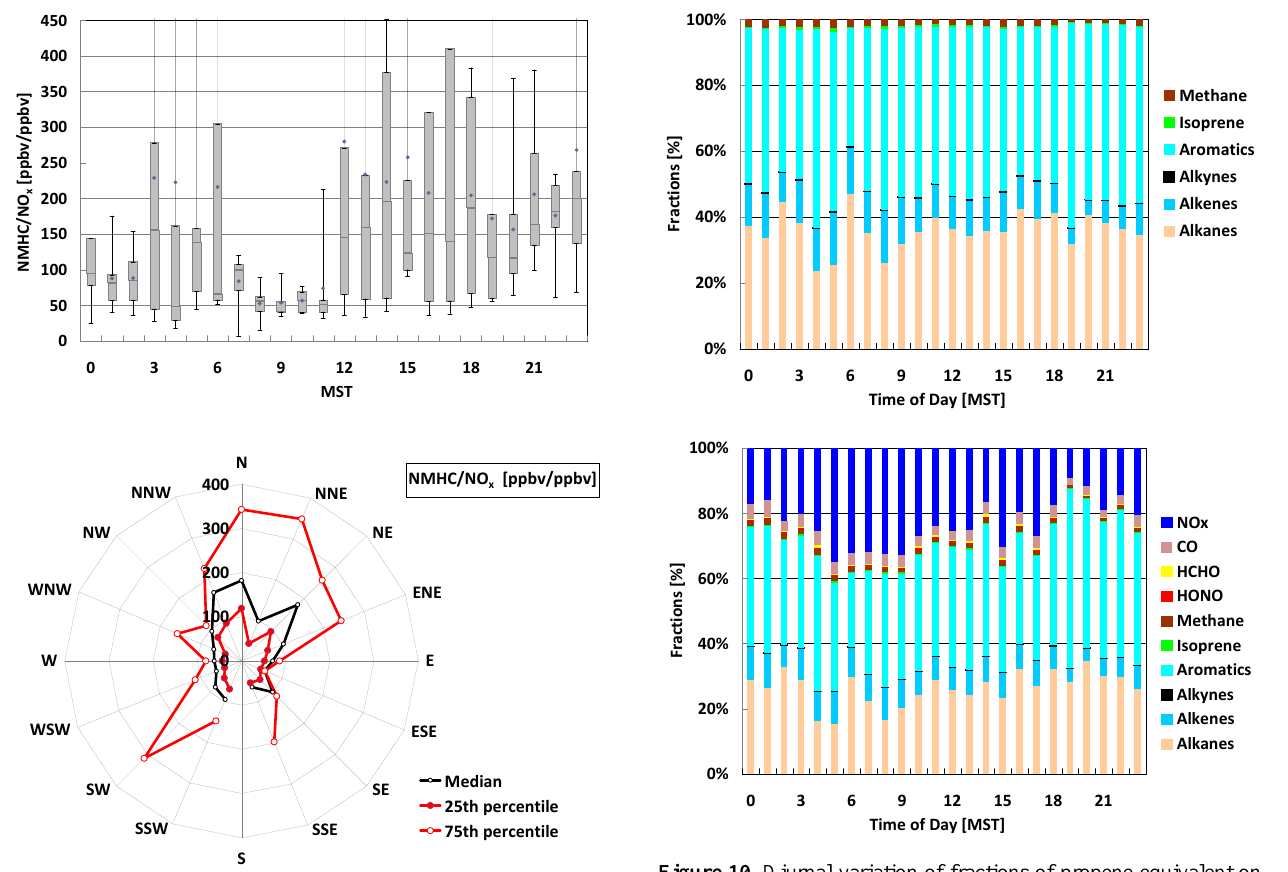
Figure 9. Diurnal and wind directional variation of the NMHC/NO x ratio at the Boulder site on IOP days. Units shown in brackets for the wind directional variation plots refer to the radial direction of the corresponding trace gas plot.